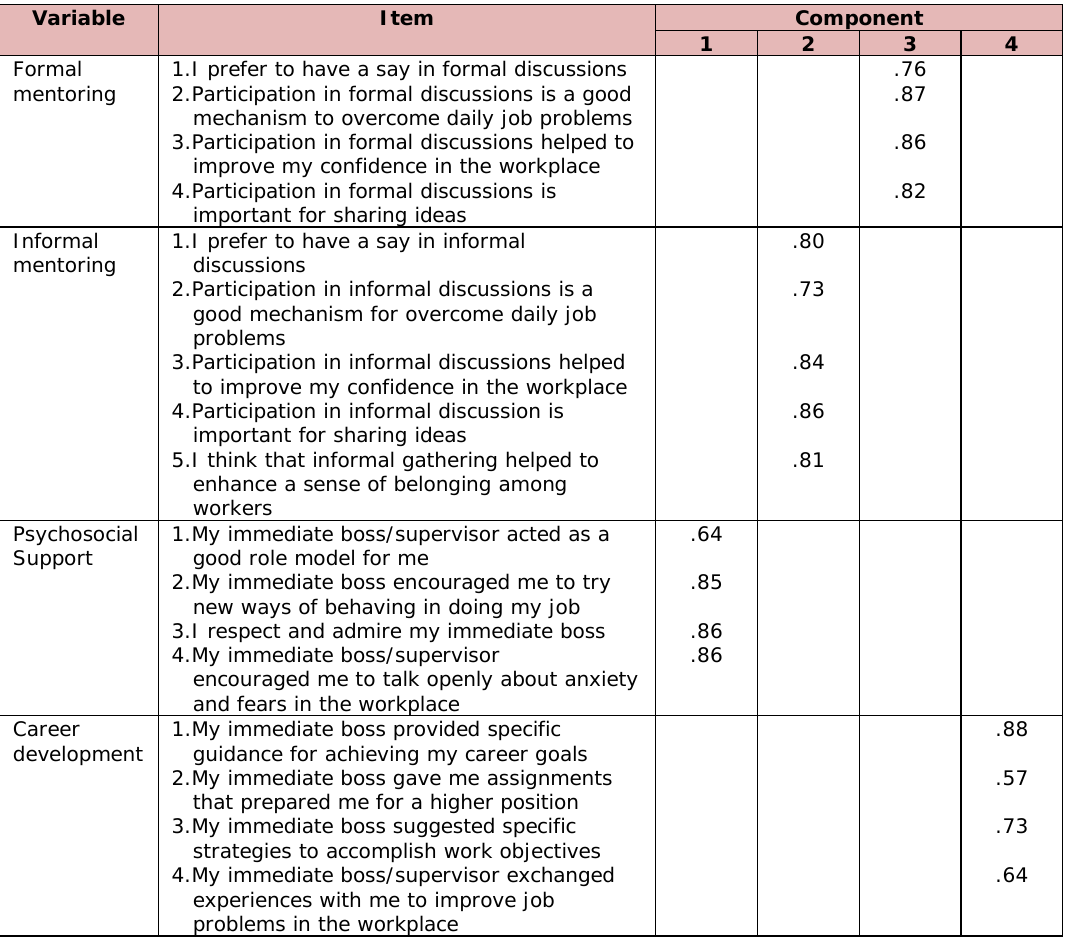
Table 2. “Measurement Scales”. Source: